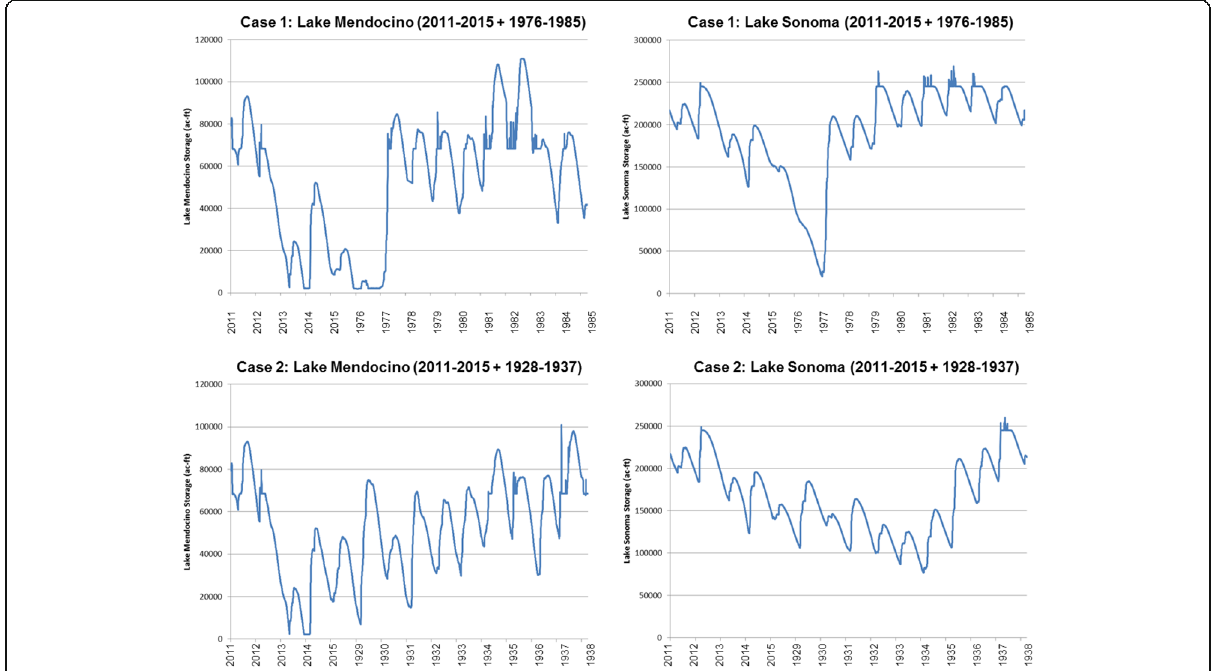
Fig. 7 Simulated reservoir storage for two extreme drought scenarios, case 1 (2011 – 2015 + 1976 – 1985) and case 2 (2011 – 2015 + 1976 – 1985)